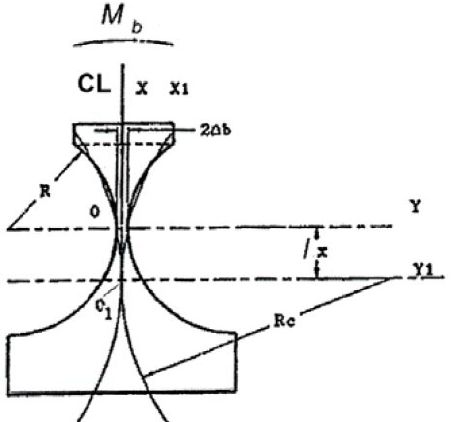
Figure 5. Concave contour R with center point O and center line CL approximation by with contiguity in point O circles R c (reprint from [1], presented with the Springer permission).